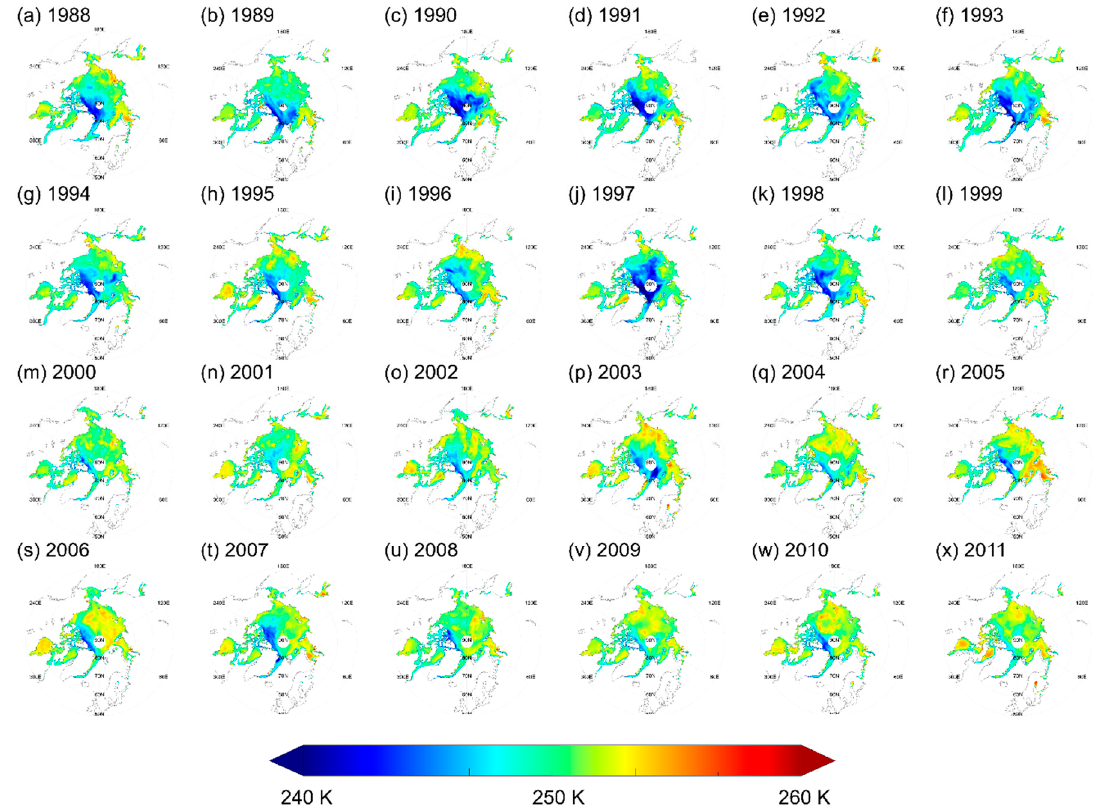
Figure 8. ( a – x ) Retrieved December Arctic snow/ice interface temperature from SSM/I FCDR data from 1988 to 2011.